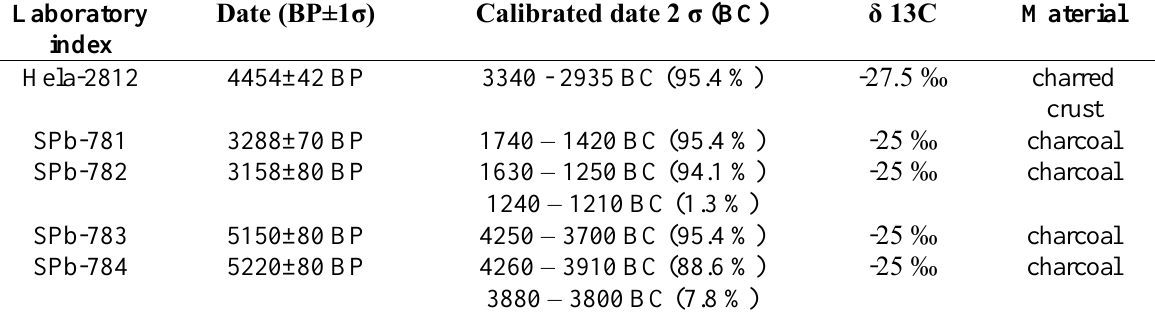
Table 1. Radiocarbon dates from Fofanovo XIII workshop site. (Atmospheric data from Reimer et al. 2004; OxCal v3.10 Bronk Ramsey